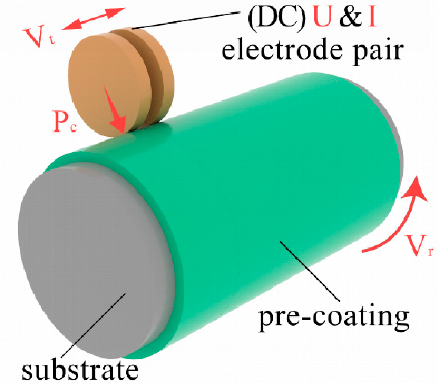
Figure 2. Coating preparation procedure.